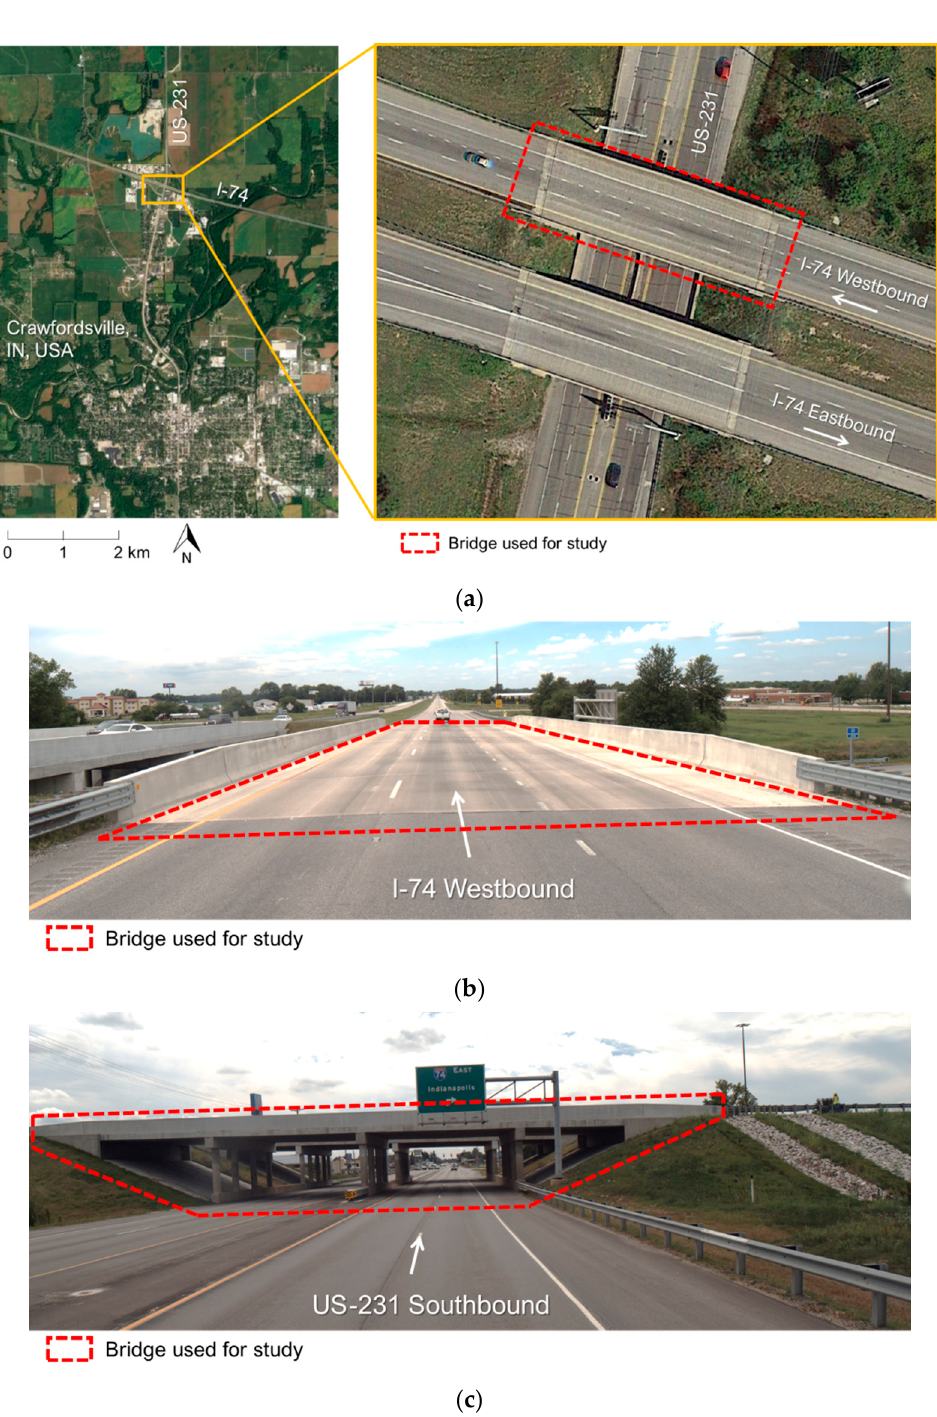
Figure 2. Study site: ( a ) the westbound bridge at the intersection of the I-74 and US-231 near Crawfordsville in Indiana, USA (aerial photo adapted from Google Earth images), ( b ) image of the bridge captured by PWMMS-HA while driving westbound on the I-74, and ( c ) side view of the bridge captured by PWMMS-HA while driving southbound on the US-231.